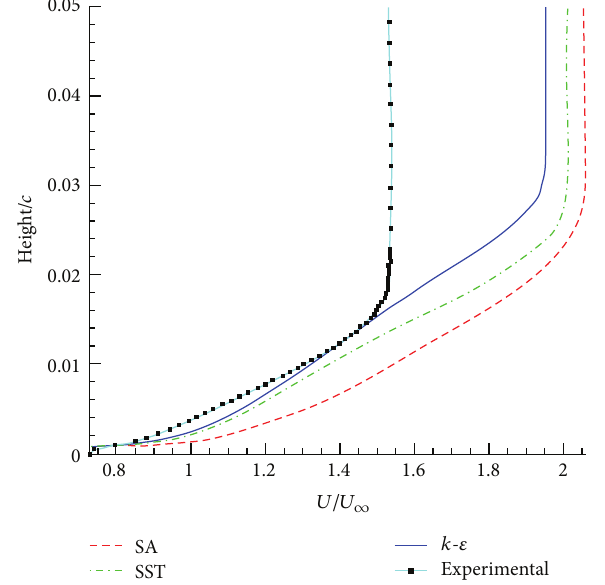
Figure 2: Typical 𝑦 + values in the turbulent boundary layer and velocity profiles in wall units for subsonic flow over flat plate, M = 0.2, Re = 1 × 10 6 , medium grid; nozzle pressure ratio = 1.4. (Source: Menter [23], Salim and Cheah [45], and Economon and Milholen II